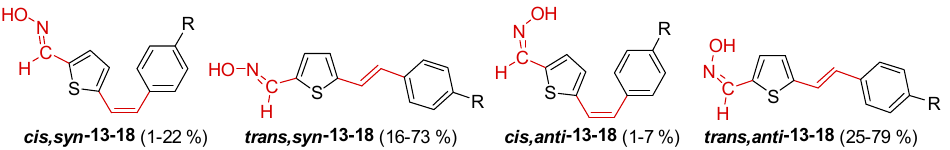
Figure 1. Ratio of geometrical isomers of the synthesized thienostilbene oximes 13 – 18 . After successive column and thin-layer chromatography, the trans,anti - and trans, syn -isomers of the individual oxime derivatives 13 – 18 were isolated at a sufficient quan- tity to test them as potential cholinesterase reactivators (see Section 2.3). During the ex- than those of syn -isomers, and due to the difference in their R f values, they are relatively easily isolated. The similarity of the R f values of the cis - and trans -isomers of the syn -ox- imes influenced the lower success of their separation. All of the isolated isomers of oxime 13 – 18 were fully spectroscopically characterized (See Figures 2 and 3, Experimental Sec- tion and Supplementary materials).